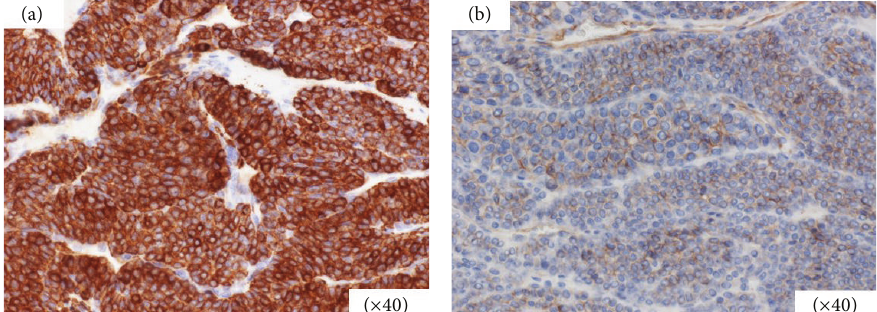
Figure 4: Immunohistological findings. Tumor cells are positive for smooth muscle actin (a) and collage type IV (b) (magnification, × 40).